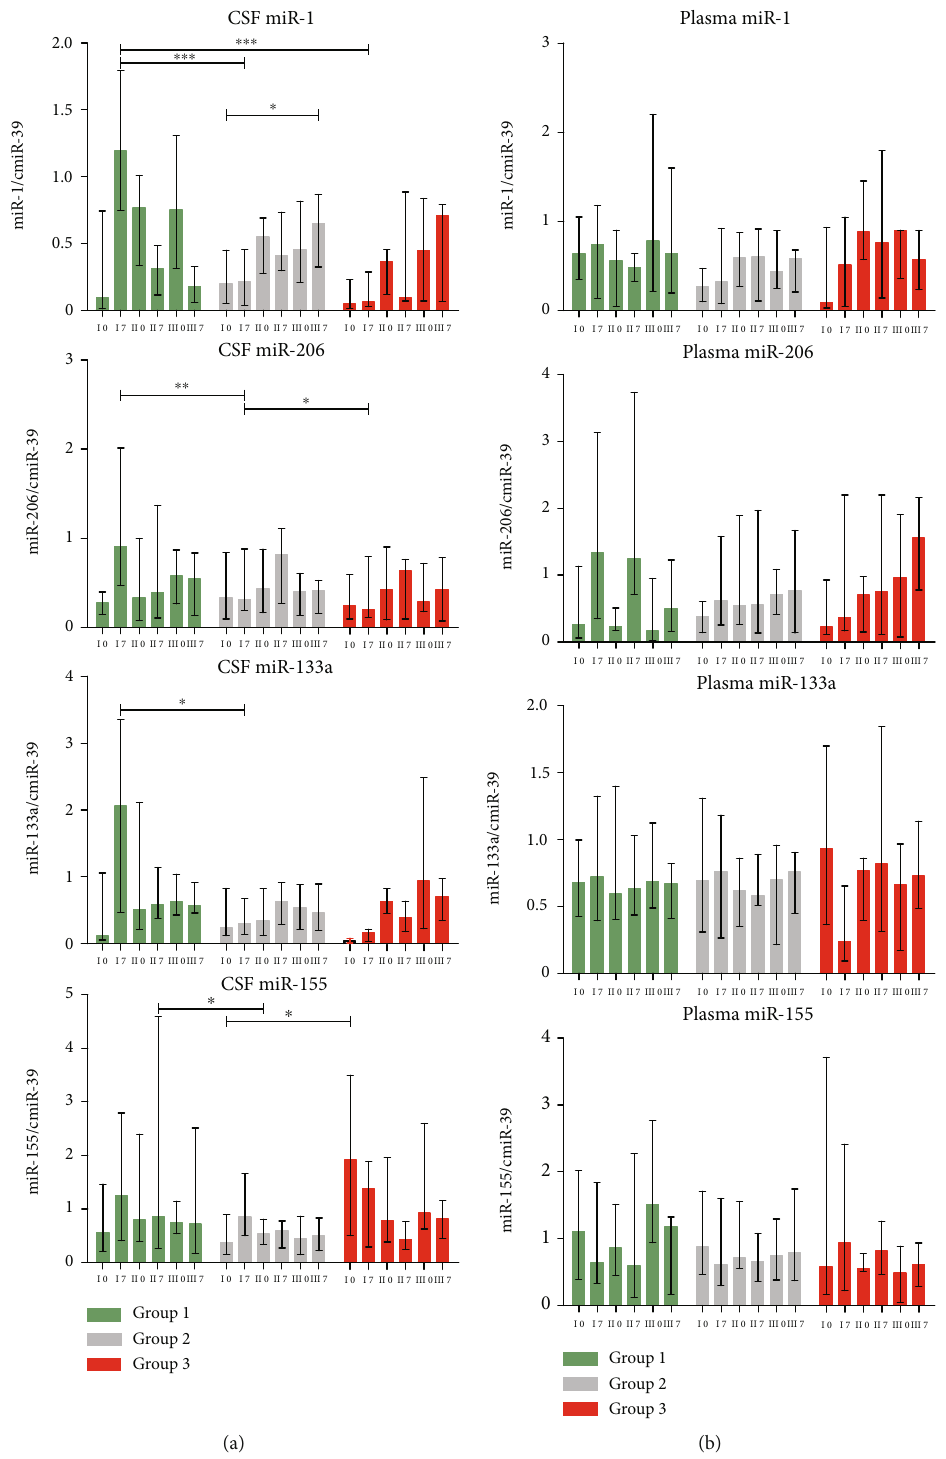
Figure 6: Results of qPCR miRNA expression analysis in (a) CSF and (b) plasma assessed in 42 sALS patients divided into three groups, based on the FDA scale results. The samples were collected in six timepoints presented on the x -axis. Roman numerals represent each Lin − cell administration (I, II, and III), and Arabic numbers stand for the day of sample collection (0 and 7). Data are presented as the median values with an interquartile range. Level of signi fi cance: ∗ p < 0 : 05 , ∗∗ p < 0 : 01 , and ∗∗∗ p < 0 : 001